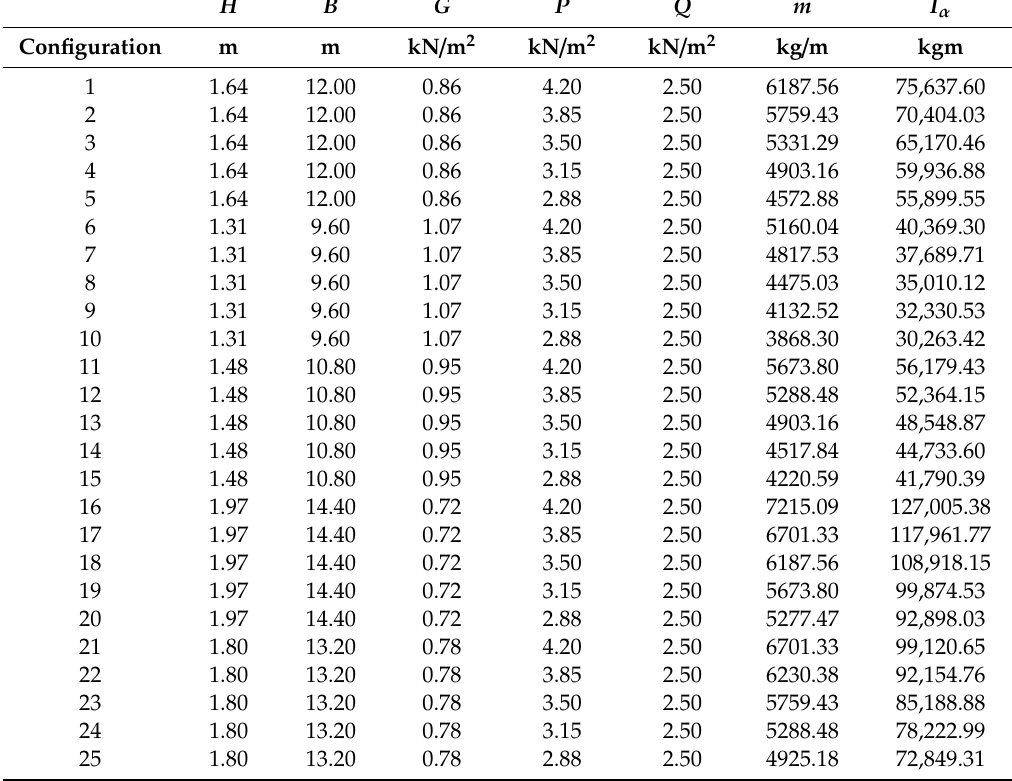
Table 2. Dimensions, structural loads, masses and inertia for the closed box section made of